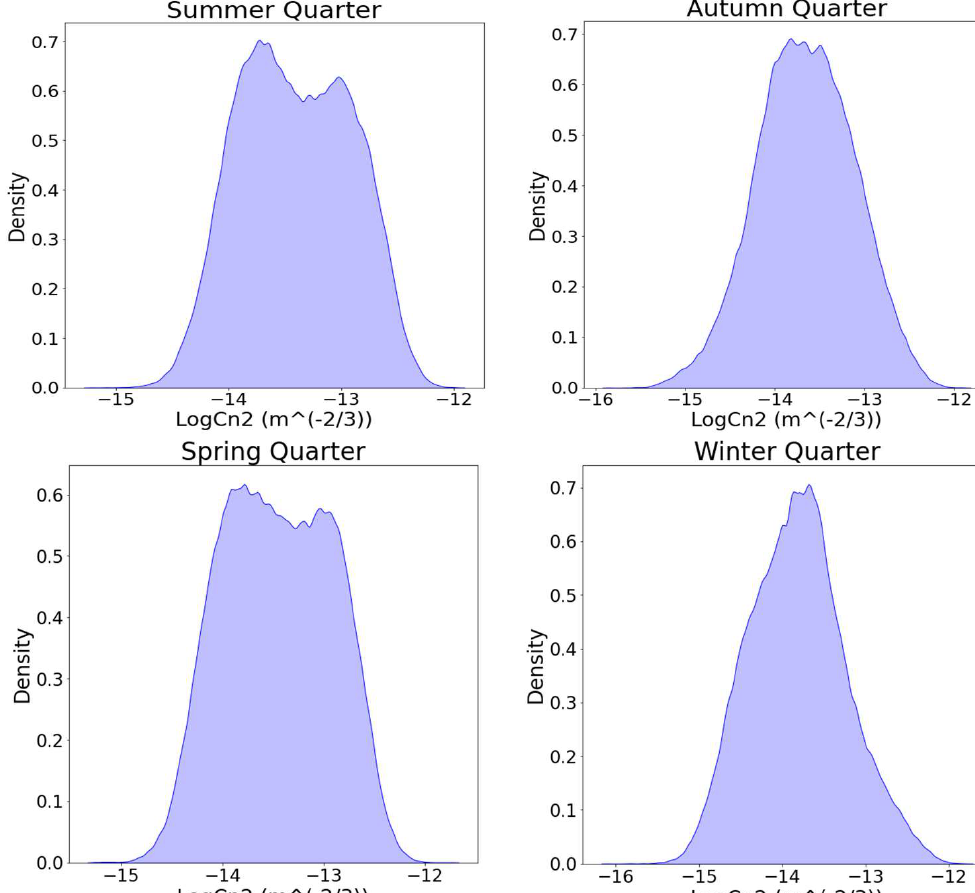
Figure 2. Distribution plots for 𝐿𝑜𝑔𝐶 (cid:3041)(cid:2870) per season.